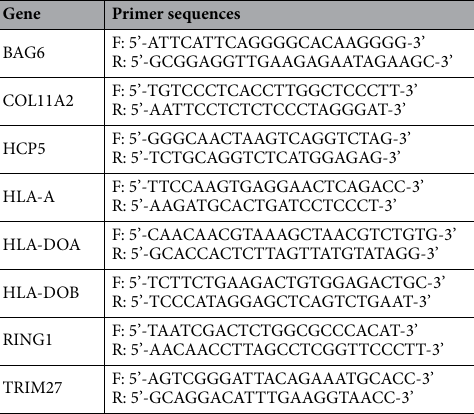
Table 3. The primer sequences for amplifying genomic region flanking the sourced SNPs. F forward primer, R reversed primer.